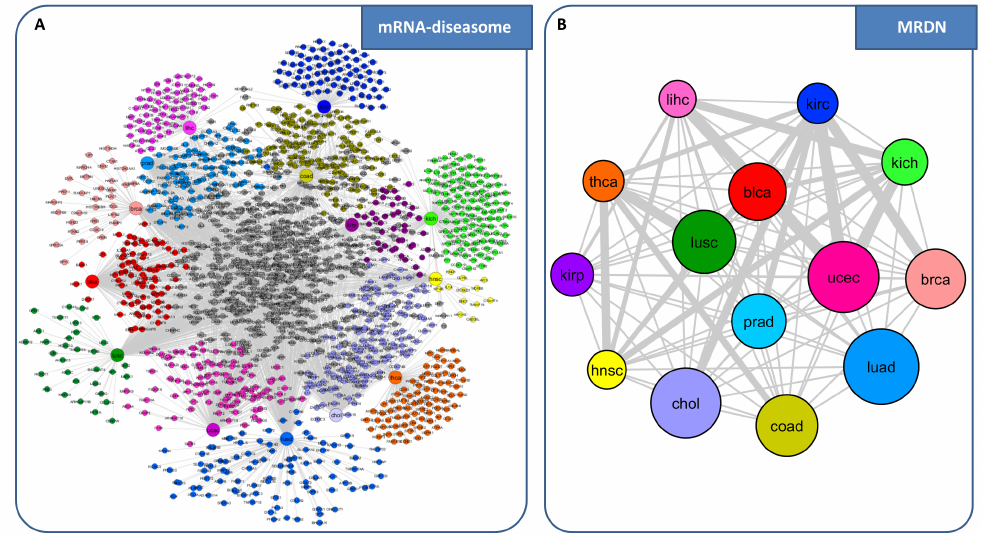
Figure 9. Comparative analysis of protein-coding genes (mRNAs) acting as switch genes in the large panel of TCGA cancer datasets. ( A ) mRNA-diseasome. The bipartite network is composed of two disjoint sets of nodes with different size: the larger ones correspond to the analyzed human cancer types from TCGA, whereas the smaller ones correspond to all protein coding genes acting as switch genes. A link occurs between a tumor type and a mRNA if the mRNA acts as switch gene for that tumor. Different colors are associated to different tumor types. mRNAs are colored based on the tumor type to which they belong. Nodes are light gray if the corresponding miRNAs are associated with more than one tumor type. ( B ) mRNA-disease network (MRDN). The MRDN is the projection of the mRNA-diseasome bipartite network, in which nodes correspond to tumor types (diseases) and two diseases are connected if there is at least one mRNA that acts as switch gene in both. The width of a link is proportional to the number of mRNAs that are acting as switch genes in both diseases. The size of a node is proportional to the number of mRNAs acting as switch genes for that disease. Different node colors are associated with different